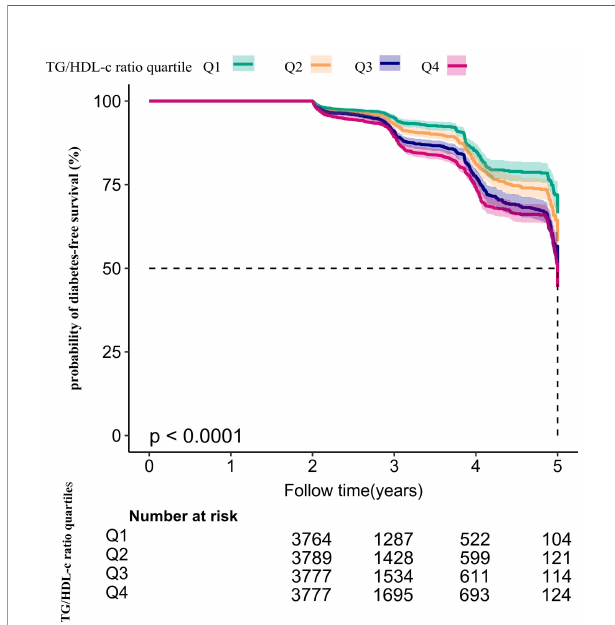
FIGURE 5 | Kaplan – Meier event-free survival curve. Kaplan – Meier event-free survival curve. The probability of diabetes-free survival differed signi fi cantly between the TG/HDL-c ratio quartiles (log-rank test, P < 0.001). The probability of diabetes-free survival gradually increased with increasing TG/ HDL-c ratio, suggesting that the group with the highest TG/HDL-c ratio had the highest risk of